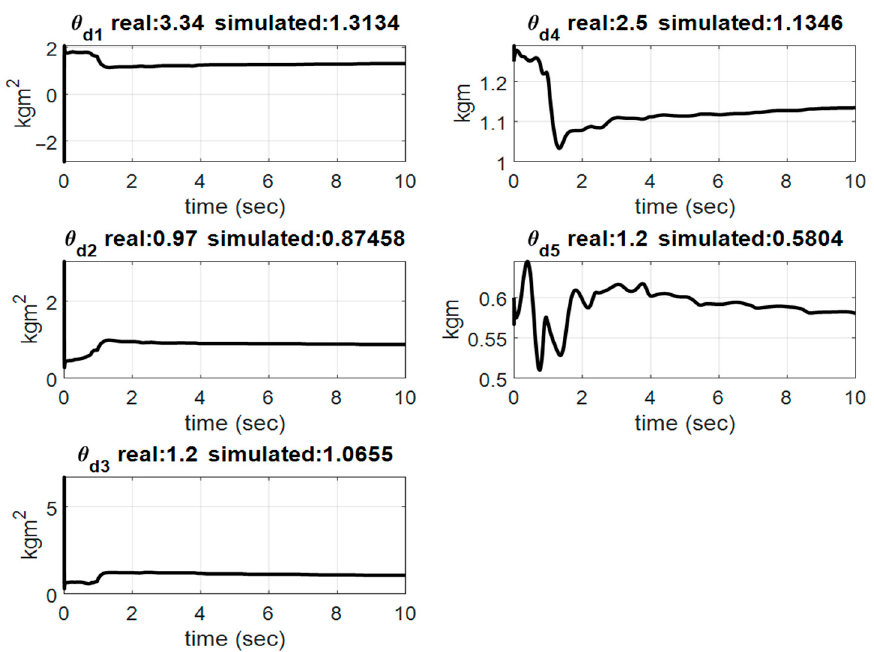
Figure 5. Estimates of dynamic parameters.